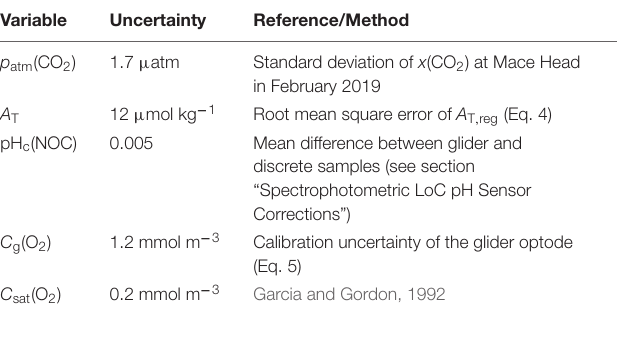
TABLE 2 | Uncertainties associated with ACP and AOU input variables.